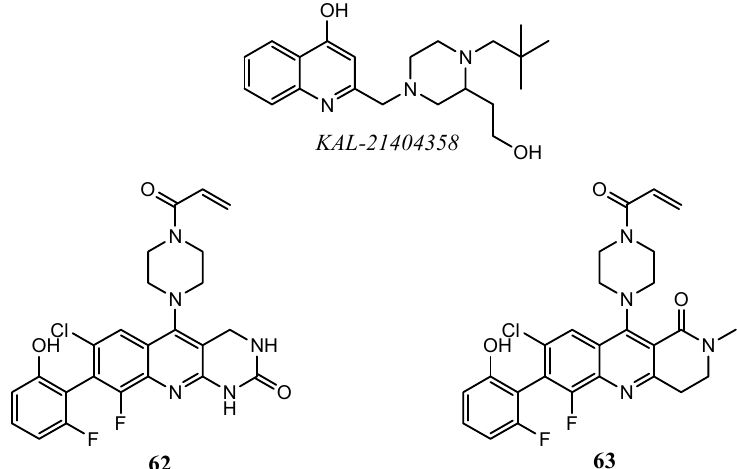
Figure 34. Quinoline-based molecules with inhibition activity on Ras.